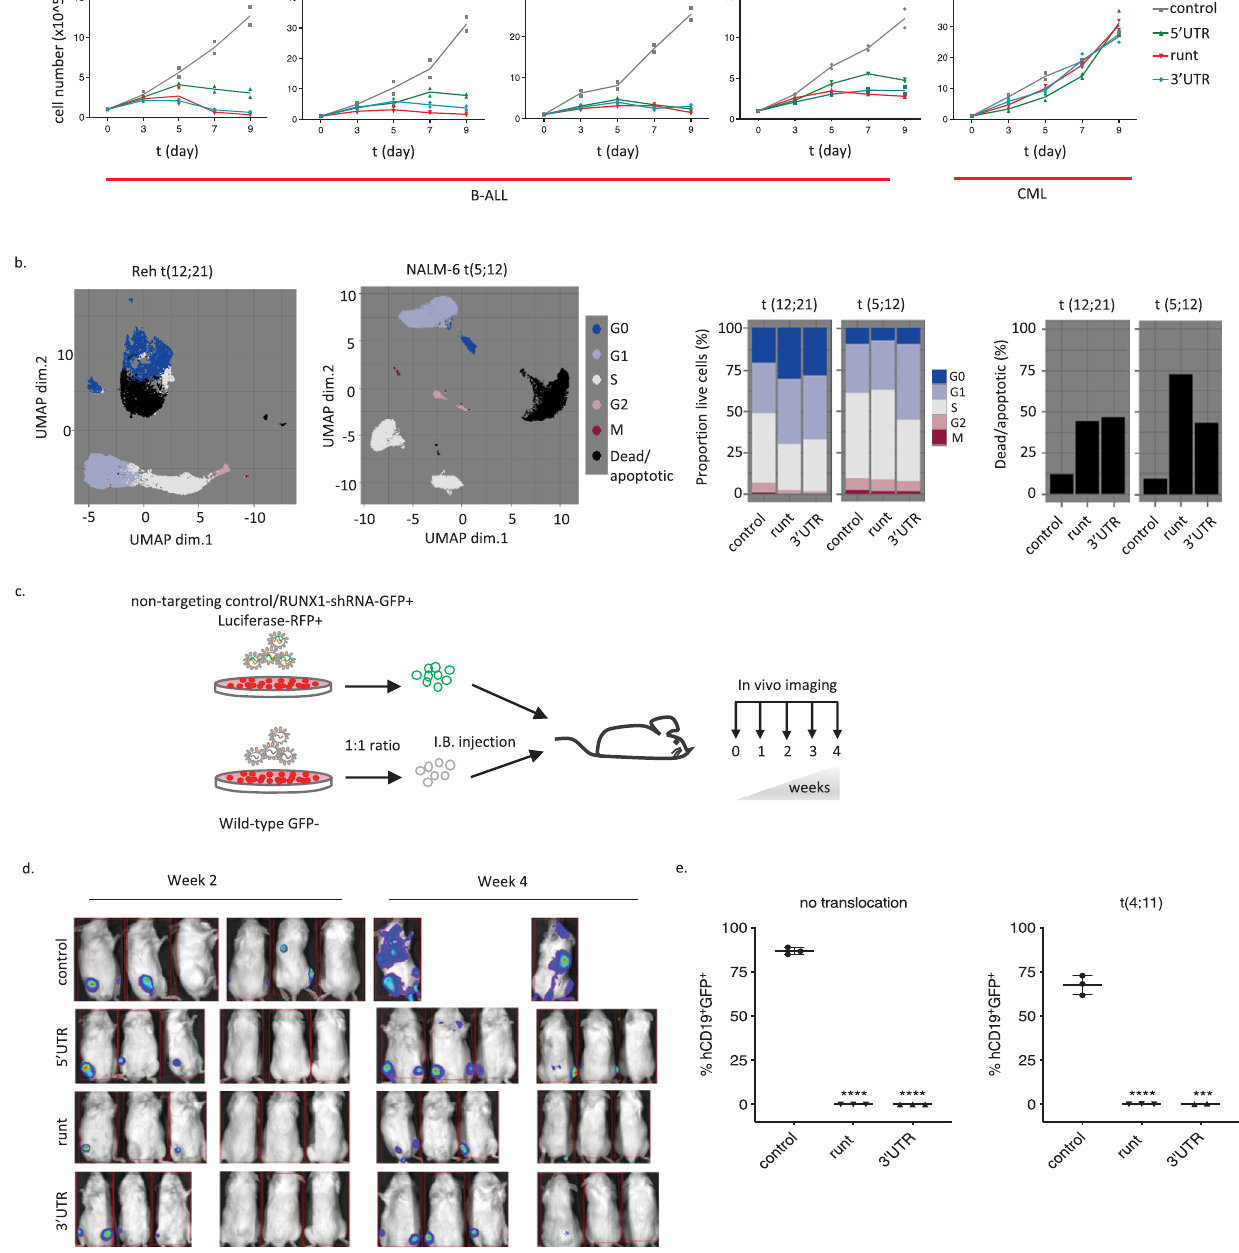
Fig. 7 | B-ALL cell lines and primary patient cells are dependent on RUNX1 activity for survival in vitro and in vivo. a Growth curves for the indicated cell lines over 9 days following transduction with shRNAs targeting RUNX1 or a non- targetingcontrol;n=2biologicallyindependentsamples. b Masscytometryanalysis for the indicated cell lines following transduction with shRNAs targeting RUNX1 (runt: t(12;21): 18259 cells, t(5;21): 823659 cells; 3 ′ UTR: t(12;21): 20802 cells, t(5;21): 582483cells)oranon-targetingcontrol(t(12;21):12777cells,t(5;21):1084188cells). UMAP projections based on cell cycle and viability/apoptosis markers. Colors representmanuallyannotatedSOMclusters.Barplotsshowproportionoflivecells in the indicated cell cycle phases and the proportion of dead/apoptotic cells. c Schematic of competitive engraftment experiments. NALM-6 cells transduced with shRNAs (GFP + ) and stably expressing a luciferase/RFP reporter were mixed 1:1 with non-transduced (GFP − ) cells and injected into NSG mice. Mice were imaged weeklyforluciferaseactivityandculledforend-pointanalysis(4weeks)ofleukemic